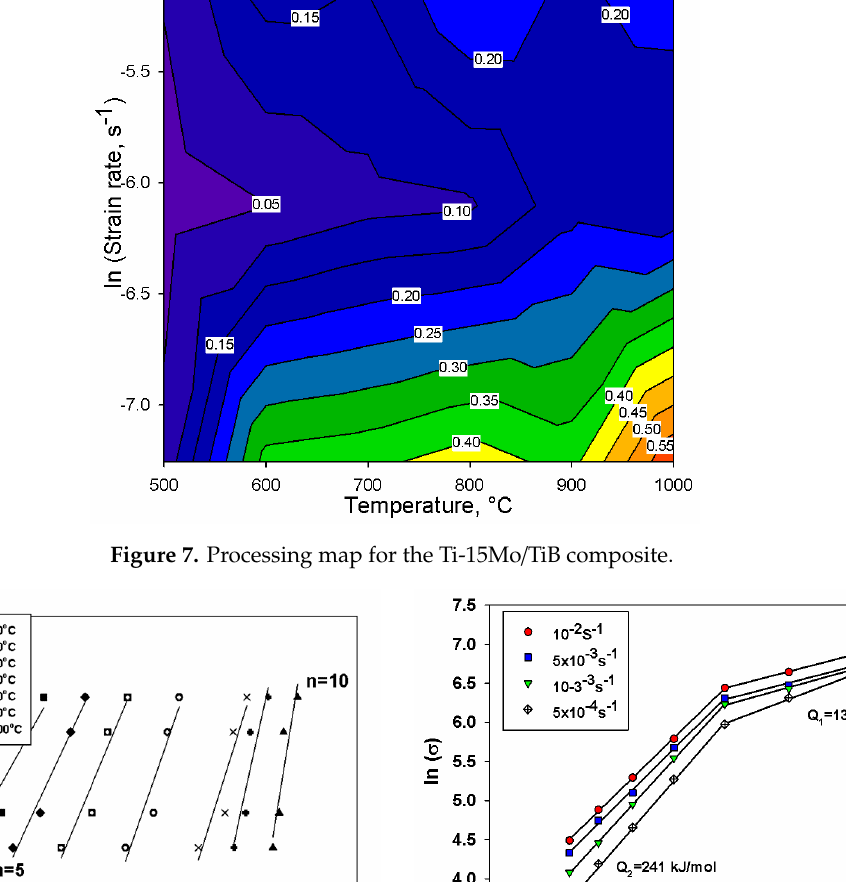
Figure 7. Processing map for the Ti-15Mo/TiB composite.